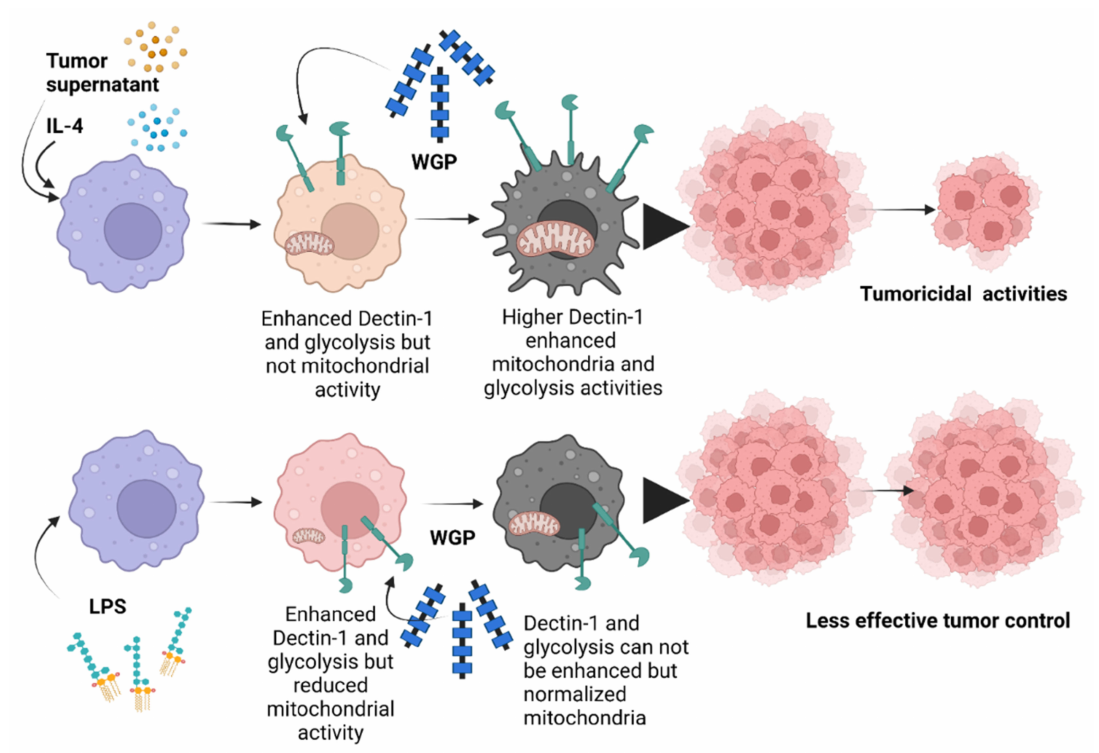
Figure 7. The proposed working hypothesis demonstrates the role of whole glucan particles (WGPs) in the enhancement of the tumoricidal activities of macrophages. While all activators, including the tumor microenvironment (using tumor supernatant for inducing tumor-associated macrophages; TAM), IL-4 (M2), and lipopolysaccharide (LPS) (M1), had an effect on upregulated Dectin-1 and increased glycolysis, LPS more prominently reduced mitochondrial activities when compared with tumor supernatant and IL-4. Then, Dectin-1 was further upregulated by WGP in non-LPS-activated macrophages (M2 and TAM) and further upregulated by WGP stimulation, leading to an elevation in glycolysis and mitochondrial activities partly through WGP-Dectin-1 activation. In parallel, the WGP-improved glycolysis was more prominent in M2 and TAM than in M1 (possibly due to the already high glycolysis present in M1) and is possibly correlated with enhanced tumoricidal activity in M2 and TAM, implying a glycolysis-dependent tumoricidal effect. The picture was created by BioRender.com and is available online: https://app.biorender.com/ (accessed on 7 August